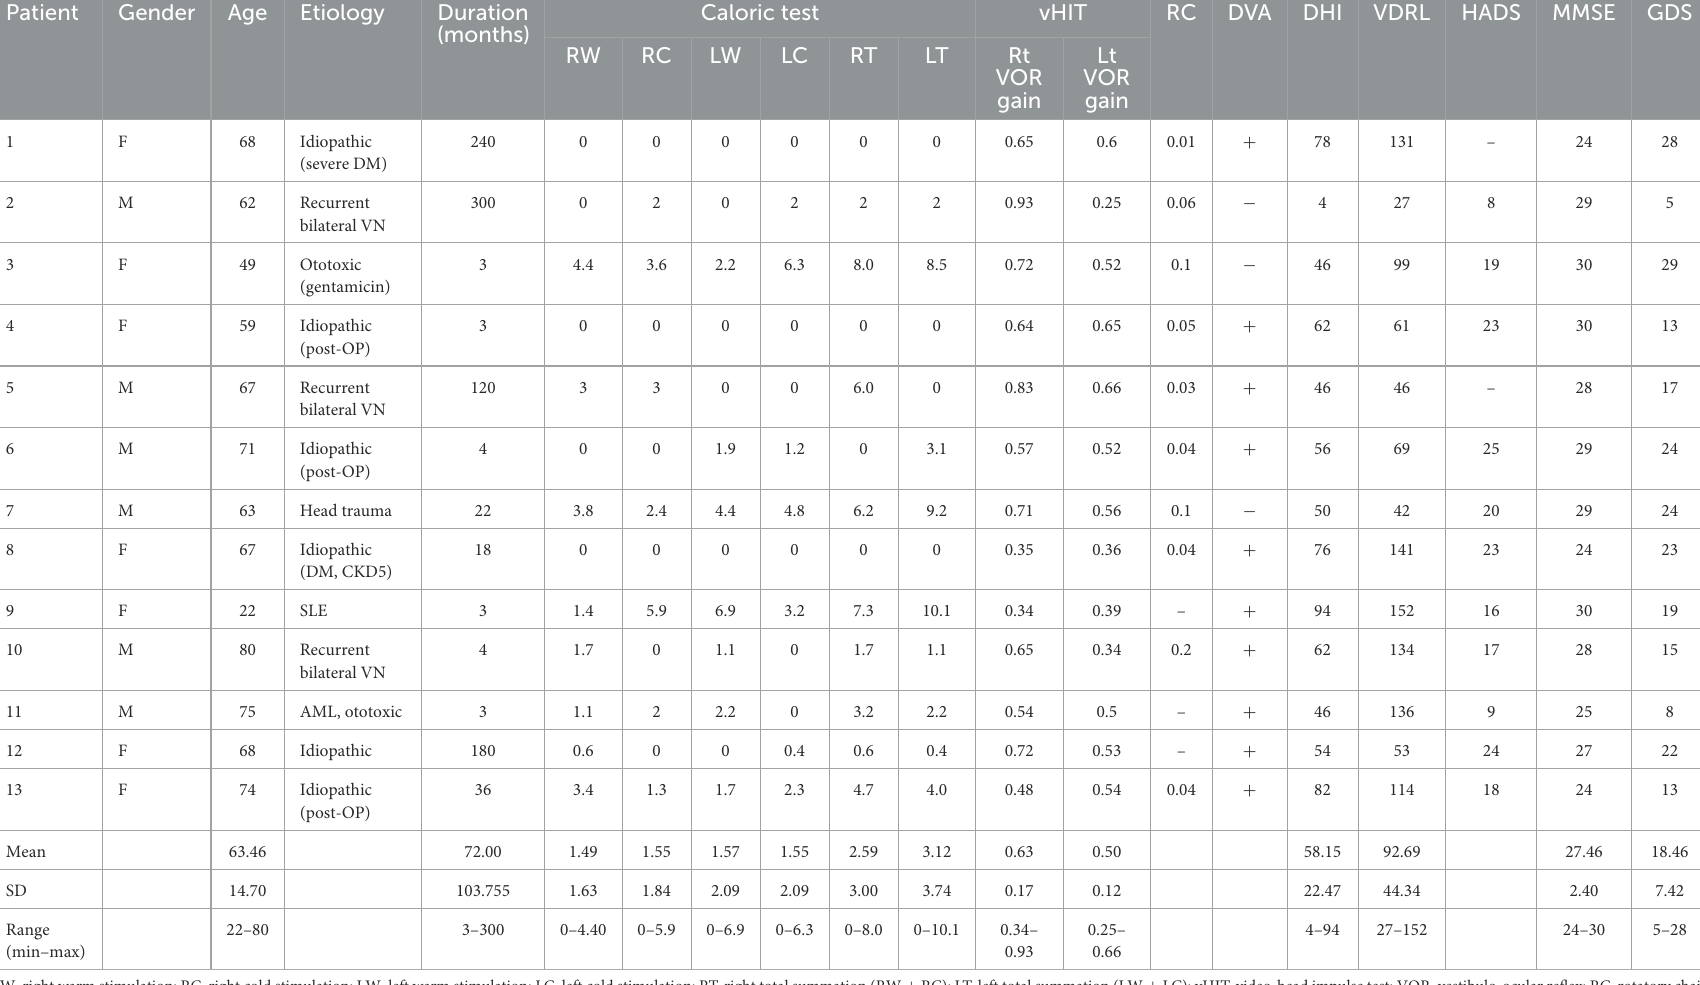
TABLE 2 Demography and vestibular function tests of patients with bilateral